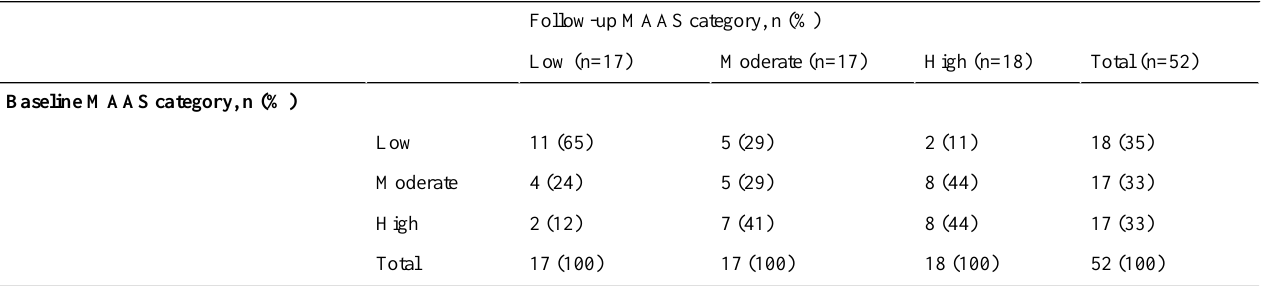
Table 4. Categorical outcomes from baseline and follow-up MAAS a .